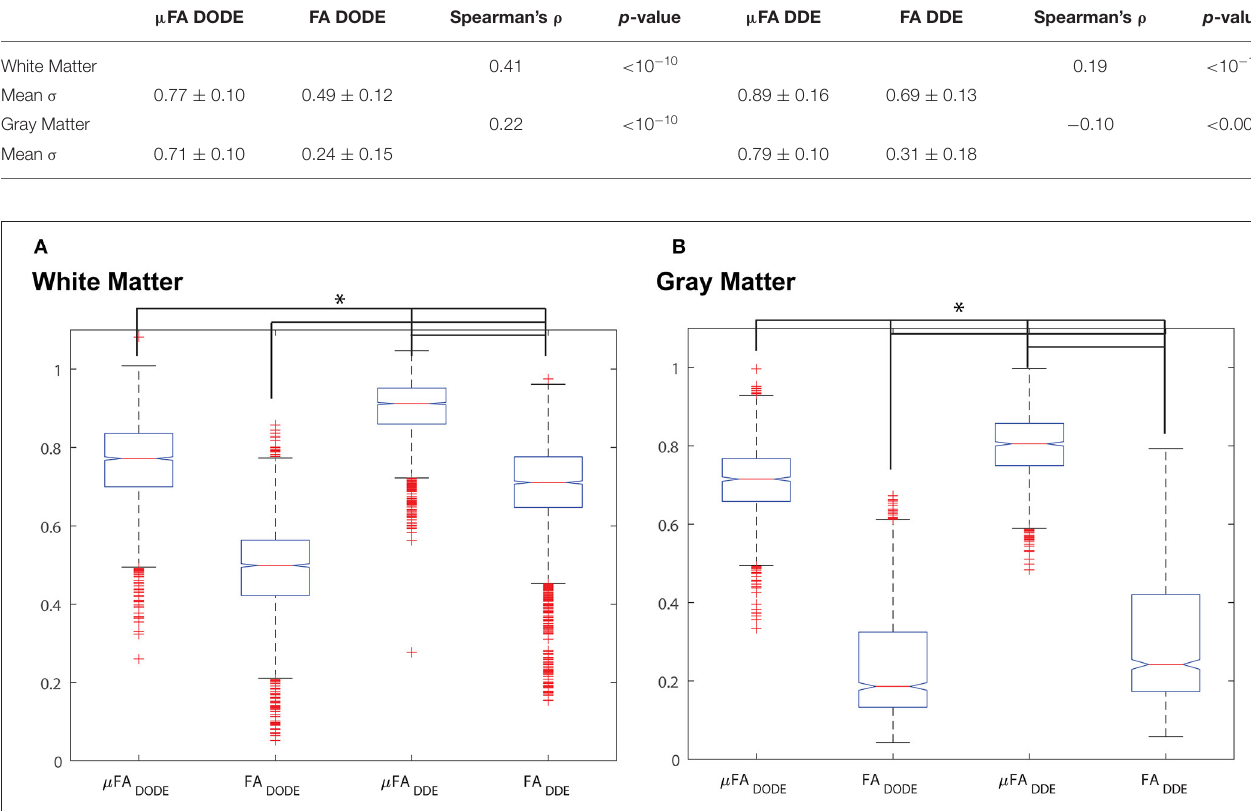
and FA DODE are correlated in white matter (Spearman’s ρ = ∼ 0.41), µ FA DDE and FA DDE metrics are only weakly correlated (Spearman’s ρ = ∼ 0.19). In gray matter, the and (Spearman’s ρ = 0.22 and − 0.10 for DODE and